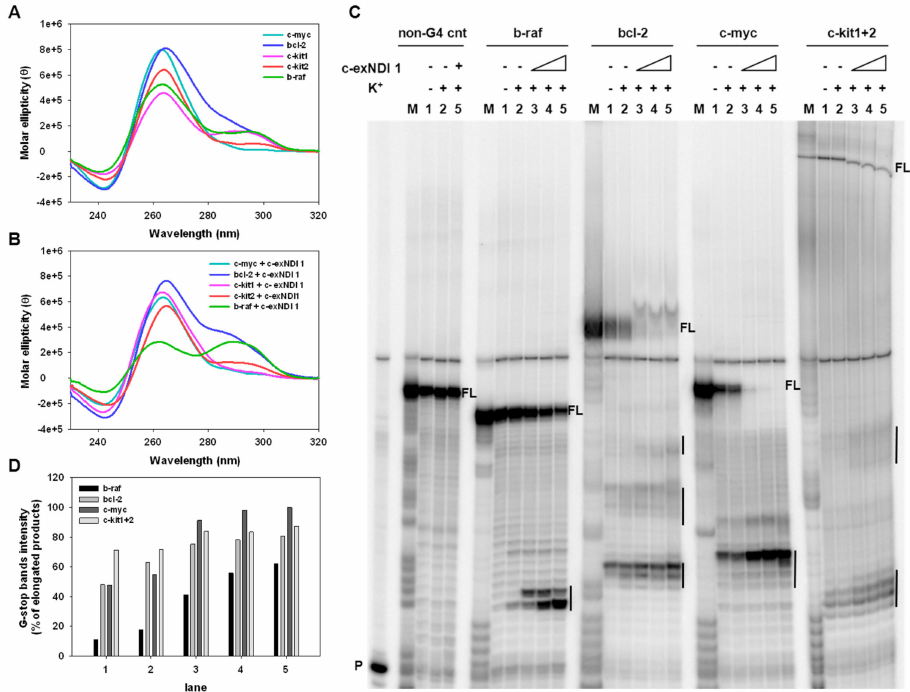
Figure 2. Representative circular dichroism (CD) spectra of G4s formed by c-myc, bcl-2, c-kit1, c-kit2, and b-raf oligonucleotides (4 µ M) recorded in the absence ( A ) or presence ( B ) of a 4-fold excess of 1 (16 µ M). ( C ) Image of a typical Taq polymerase stop assay. The b-raf, bcl-2, c-myc, and c-kit1 + 2 templates were amplified by Taq polymerase in the absence (lanes 1) and presence of 10 mM K + , alone (lanes 2) or combined, with increasing amounts (37.5, 75.0, and 150.0 nM) of 1 (lanes 3–5). A template (non-G4 cnt) made of a scramble sequence unable to fold into G4 was also used as an internal control. Lane M: Ladder of markers obtained by the Maxam and Gilbert sequencing carried out on the amplified strand complementary to the template strand. Lane P: Unreacted labelled primer. Vertical bars indicate G4-specific Taq polymerase stop sites. ( D ) Quantification of the intensity of G4 stop bands obtained in the Taq polymerase stop assay. G4 stop band intensities are expressed as percentages with respect to the total elongated